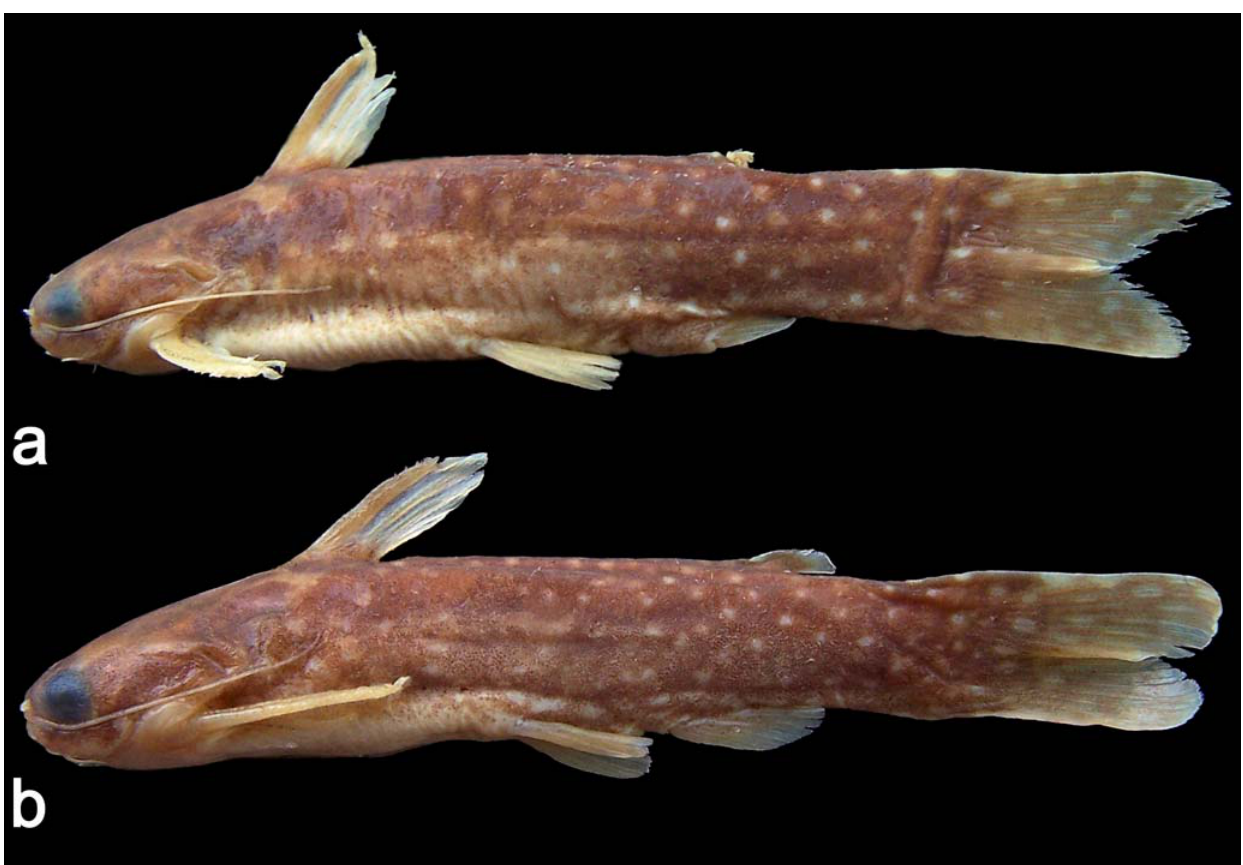
Fig. 22. Tatia galaxias . (a) ANSP 138105, male, 64.6 mm SL. (b) ANSP 138105, female, 54.2 mm SL, El Viento rivulet,